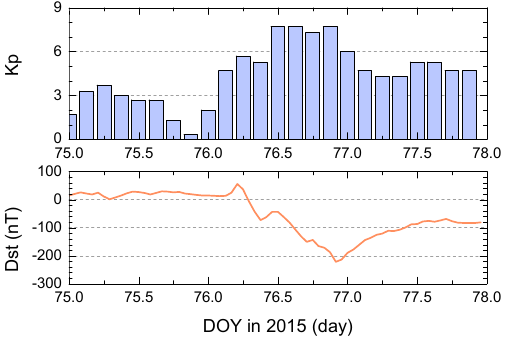
Figure 9. Kp and Dst variations during DOY 075-077 in 2015 (16–18 March 2015). Large variations of Kp and Dst during the geomagnetic storm on 17 March is shown. The storm commence time is UT 0450 and the main storm phase lasts from UT 0800 to 2300 on 17 March.